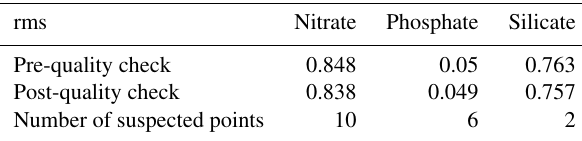
Table B1. Summary of the quality check analysis quality assurance of the 1981–2017